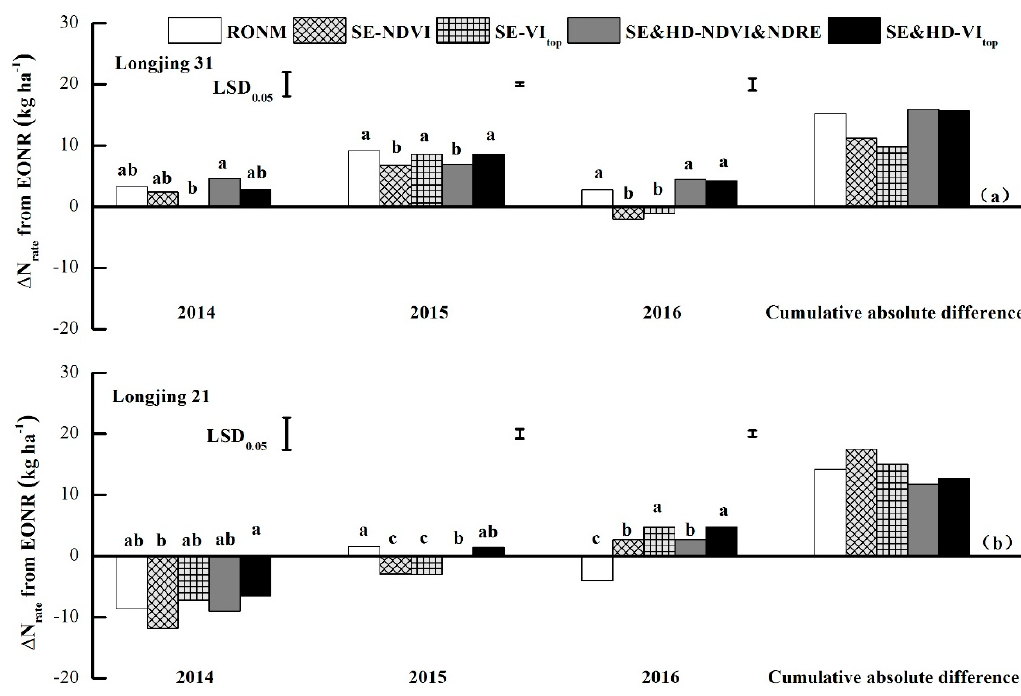
Figure 7. The difference of recommended topdressing N application rate ( Δ N rate ) from economically optimal N rates (EONR) between RONM strategy and RapidSCAN sensor-based PNM strategies for the rice varieties of Longjing 31 ( a ) and Longjing 21 ( b ) under optimal N status before topdressing (N120) in 2014–2016. RONM: the regional optimum N management topdressing N rate (36 kg N ha -1 in this study). SE-NDVI and SE-VI top indicated recommended topdressing N application rates calculated by the models using NDVI and the top performing VIs (VI top ) for different varieties at stem elongation stage, respectively. SE&HD-NDVI&NDRE and SE&HD-VI top indicated recommended topdressing N application rates calculated by the models using NDVI (at stem elongation stage) and NDRE (at heading stage), and VI top at stem elongation and heading stage, respectively. Vertical bars represent the LSD value ( p = 0.05). Different letters indicate significant difference at p < 0.05 level within the same year.